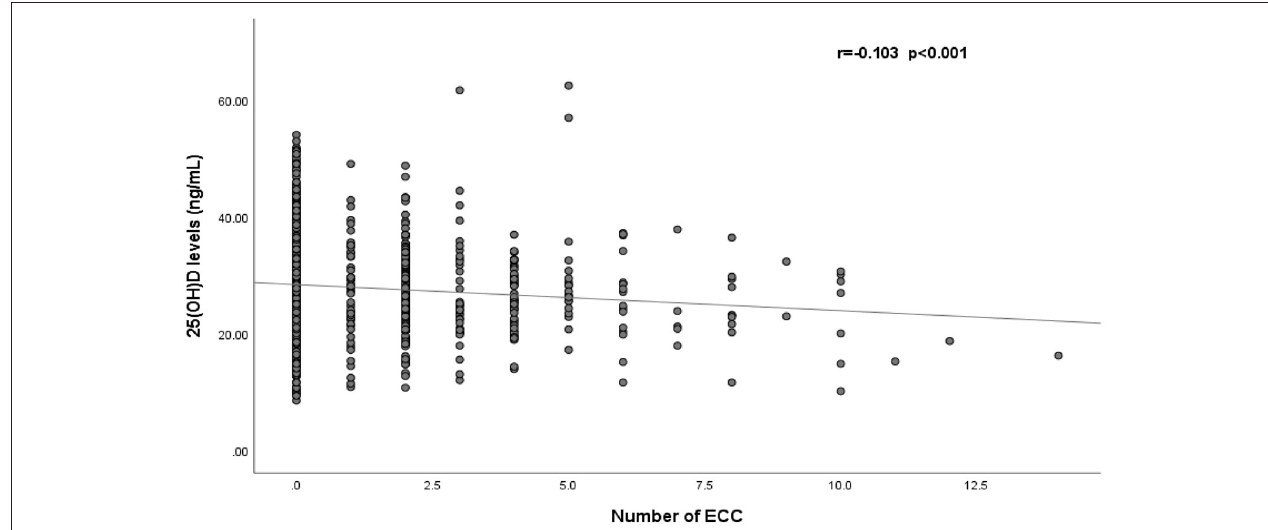
FIGURE 2 | Correlation of serum 25(OH)D levels and the number of early childhood caries ( n = 1,510). ECC, early childhood